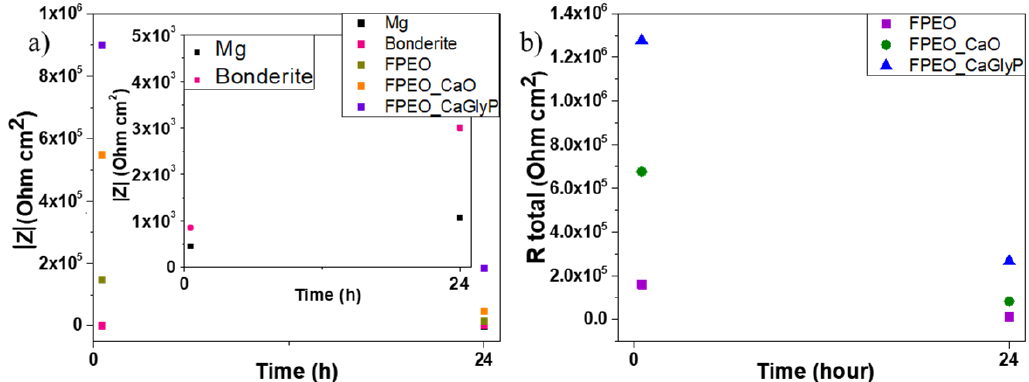
Figure 7. Evolution of the total impedance at 10 mHz ( a ) and a total coating resistance with immersion time ( b ). Inset in ( a ) shows the zoom-in on the difference between the bare substrate and the commercial Bonderite CC.